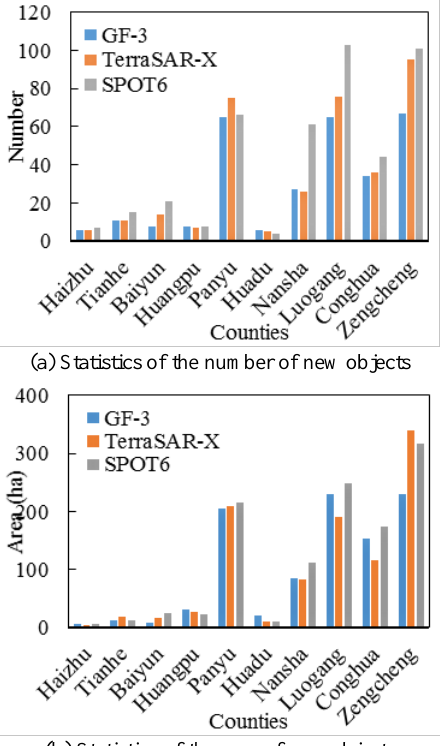
Figure 8. Statistical results of change detection for three groups of images in each county